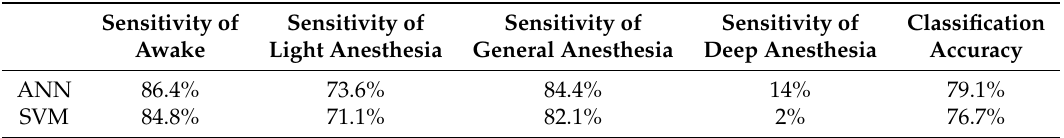
Table 4. Comparison between ANN and SVM with four features.